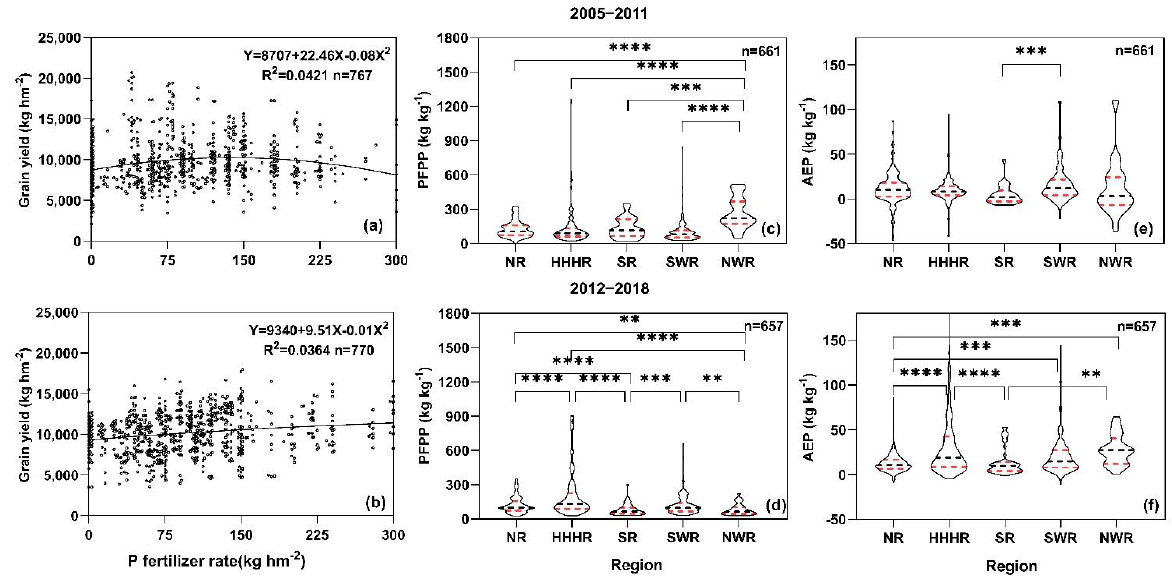
Figure 6. Relationship between maize yield and P fertilization levels in different years ( a , b ), and the comparison between the PFPP ( c , d ) and AEP ( e , f ) of five maize-growing regions in China. NR: Northern region; HHHR: Huang − Huai − Hai region; SR: Southern region; SWR: Southwestern region; NWR: Northwestern region. The black dashed lines and red dashed lines indicate the median and quartiles, respectively. **, ***, and **** represent significance levels of p < 0.01, p < 0.001, and p < 0.0001, respectively, and the absence of significance-level markings between any pair of regions indicates that their differences were non-significant.